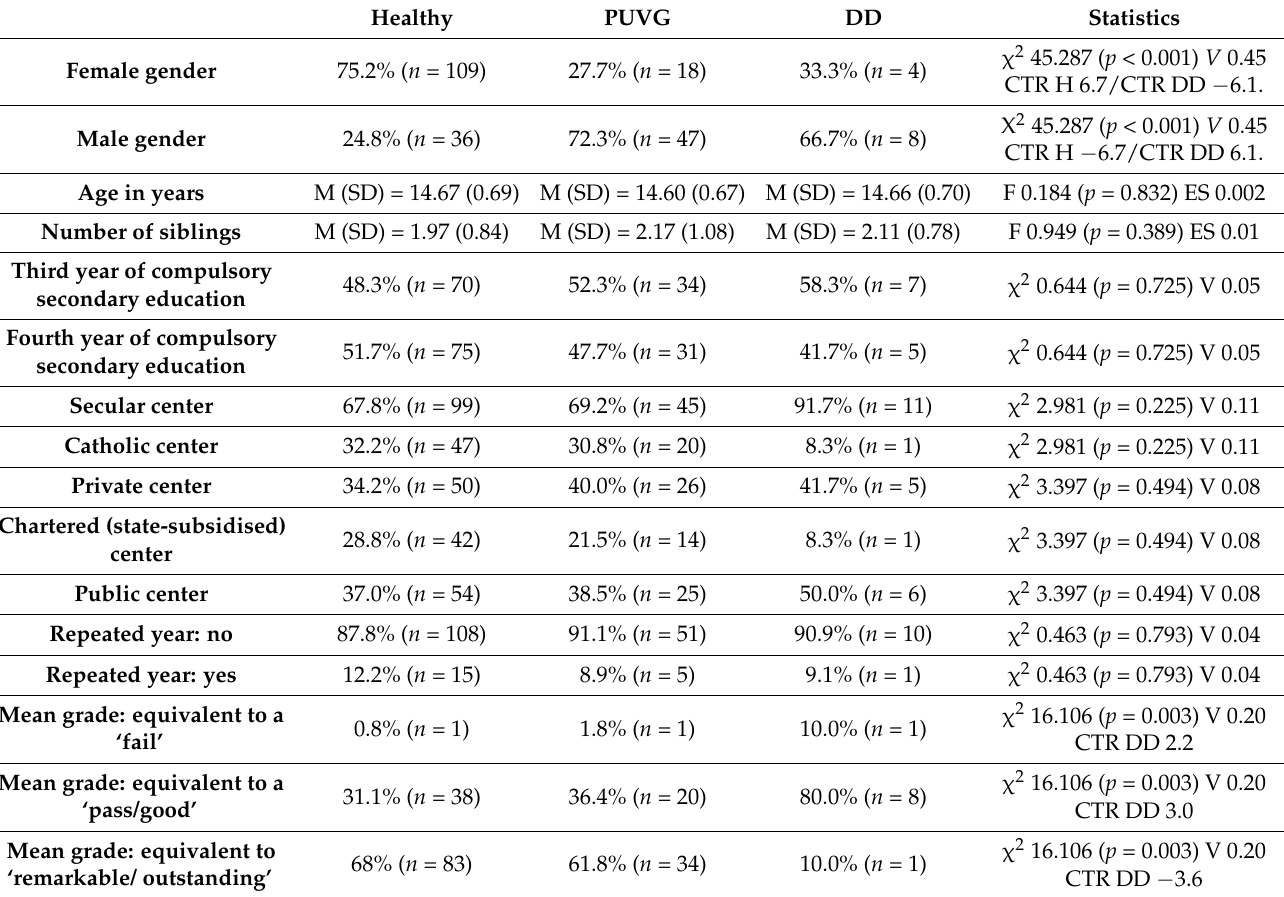
Table 1. Sociodemographic characteristics of the adolescents included in this study ( N =